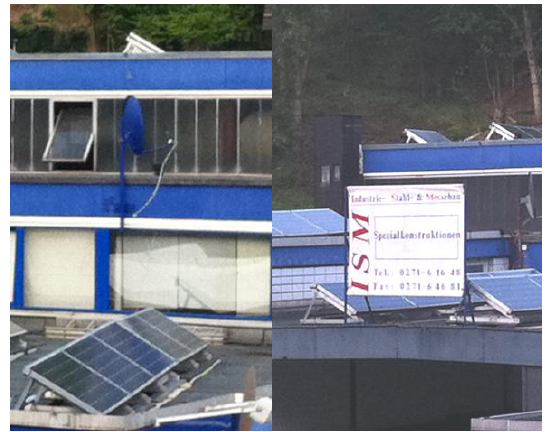
Figure 9. Shadow from a temporary objects like antenna and signboard on photovoltaic module In the right side of Figure 9 a rectangular object is blocking the photovoltaic module. This is a temporary object and might not always be present within the city model. But it has also significant impact on energy production.